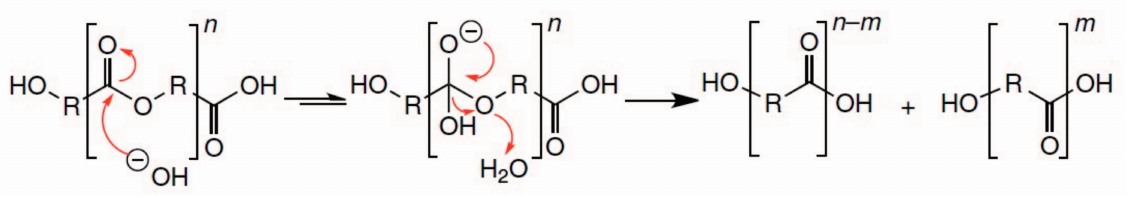
Figure 1. Alkaline-catalysed hydrolysis of polyesters, originally published in [9].